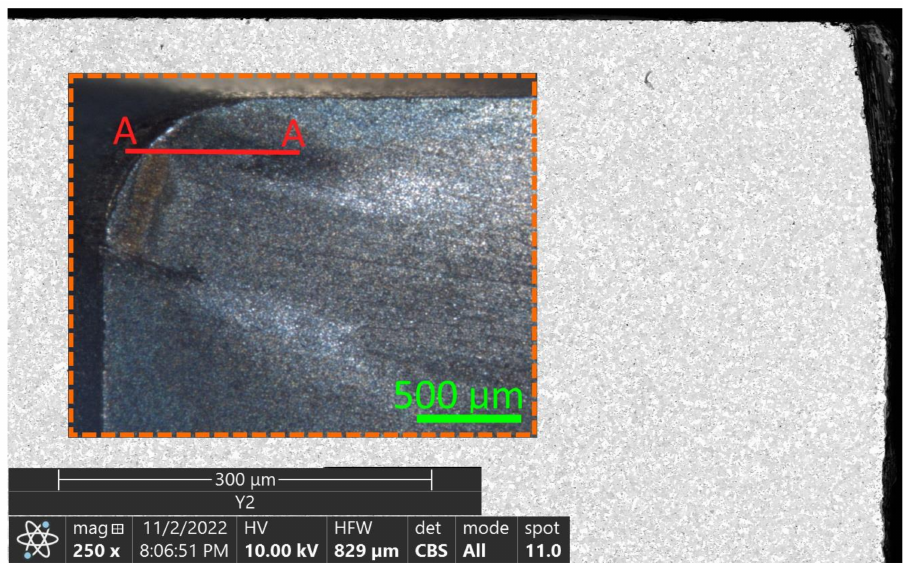
Figure 1. Transverse section of a worn insert (SEM); (center) view of a worn insert coated with (Ti,Y,Al)N and the designation of the A-A transverse section plane.